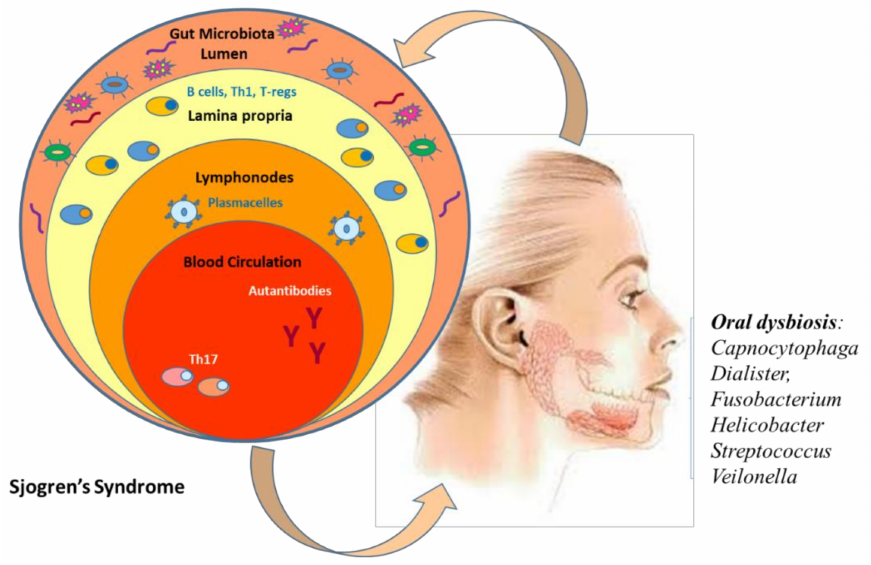
Figure 3. Oral dysbiosis in Sjogren’s